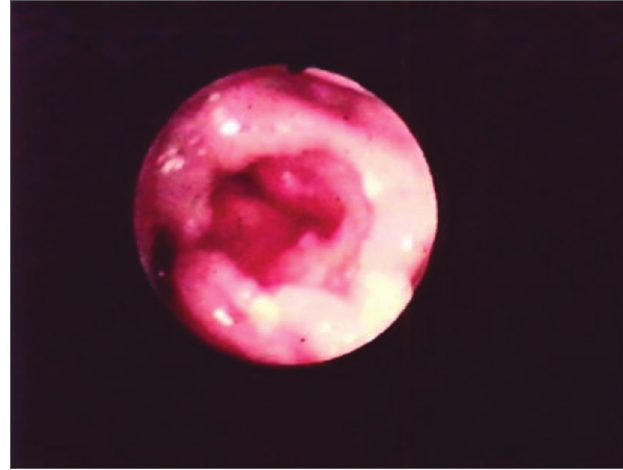
Figura 2. Edema com hiperemia em região interaritenoidea. Hiperemia de epiglote com amputação